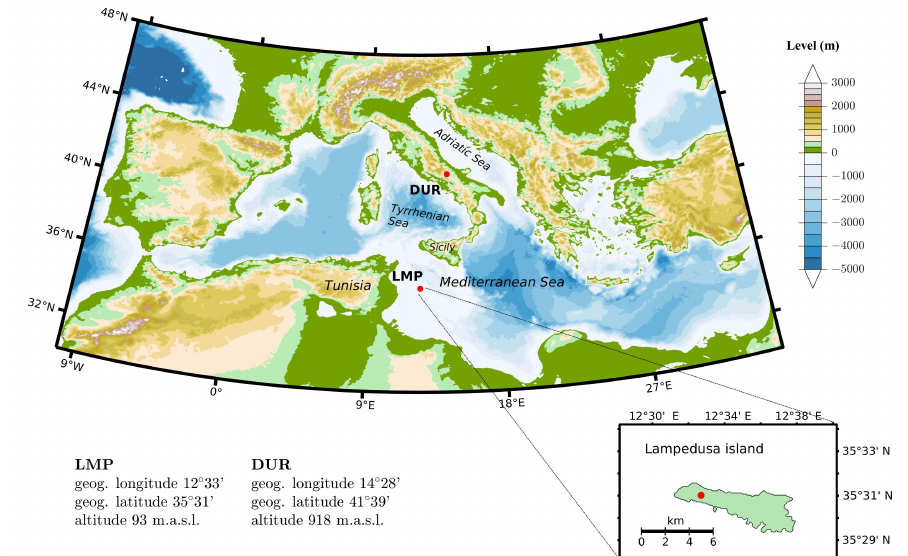
Figure 1. The location of two Italian geomagnetic observatories of LMP and DUR (red filled cir- cles) used in this work together with their geographic coordinates. Map produced by M_Map software